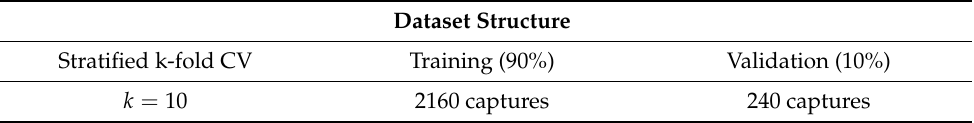
Table 3. Data partition for training and validation.